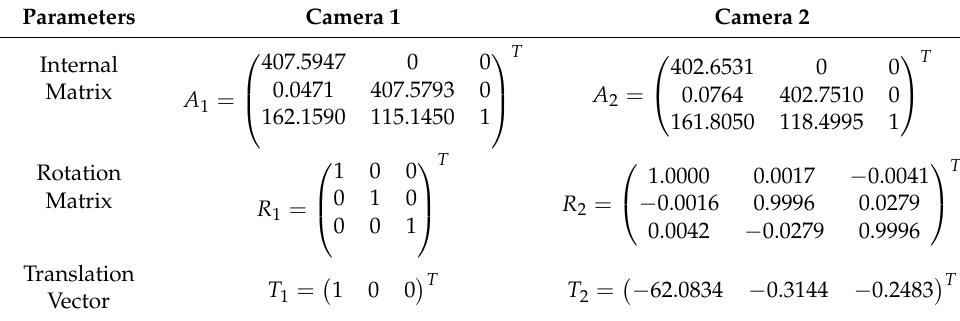
Figure 12. The calibration experiment of a binocular camera. ( a ) The physical status of one pair of images. ( b ) The distribution of the calibrated pairs of images. Table 1. Results of underwater camera calibration